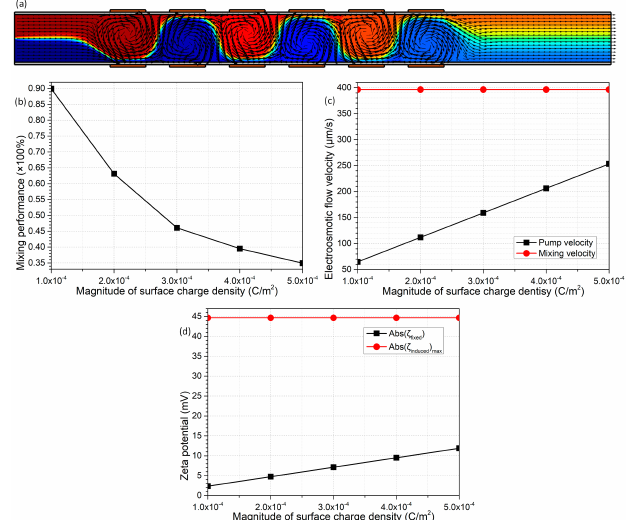
Figure 8. Effect of liquid conductivity σ f on the device performance for sextuple-alternated B-DCFFET, for given values Vs = 70 V, V G1 = − V G2 = 700 V, L G = 150 µ m and L GG = 100 µ m. ( a ) An arrow and surface plot of the electroosmosis flow field and resulting molar concentration distribution of chemical analyte (unit: mol/m 3 ) with σ f = 0.005 S/m. ( b ) σ f -dependent mixing efficiency. ( c ) Electroosmotic flow velocity in terms of pump and mixing fluid motions at varying liquid conductivities σ f . ( d ) A quantitative comparison between the magnitude of native zeta potential | ζ fixed | and maximum induced zeta potential ζ maximum at the membrane/solution interface, as a function of the medium induced conductivity σ f .